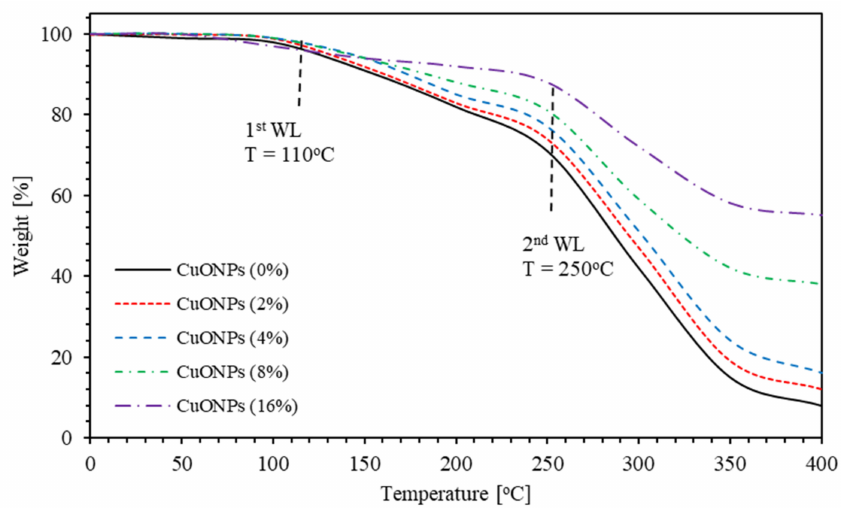
Figure 17. TGA thermograms of PMMA–PVA/CuO nanocomposite thin films for various CuO NPs